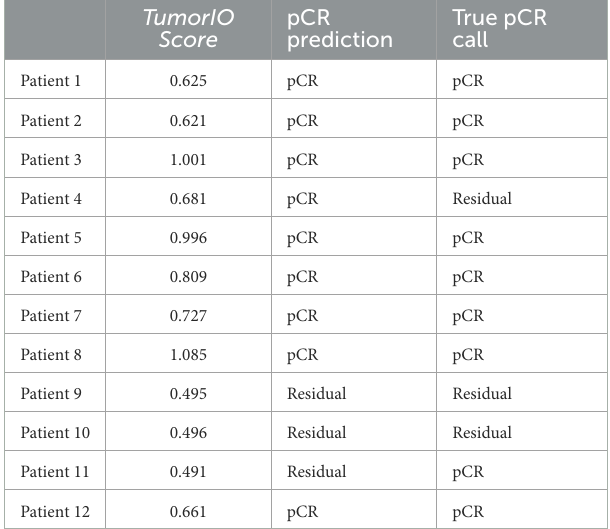
TABLE 3 Prediction of pCR in TNBC tumors (10/12 correct).